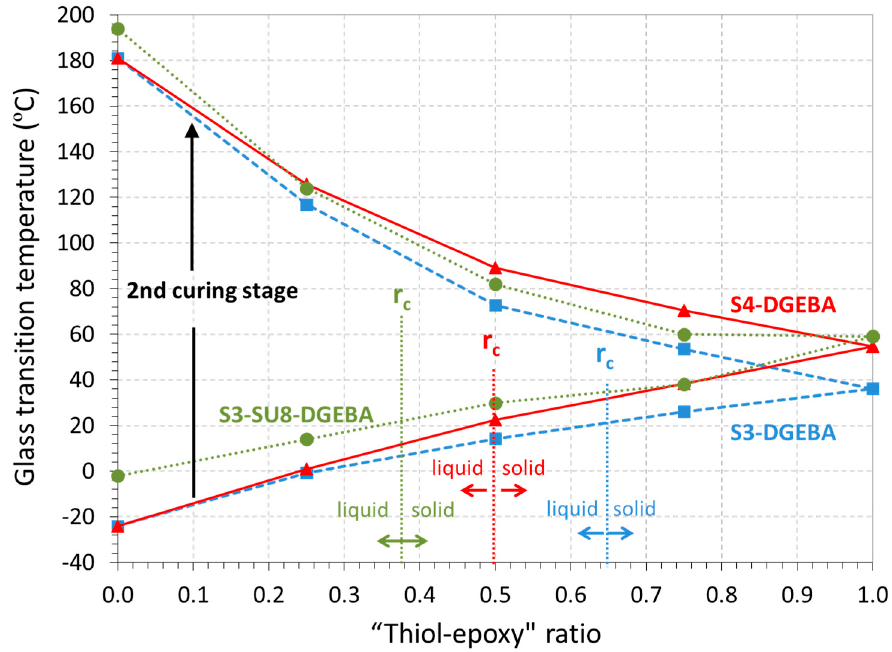
Figure 7. Glass transition temperatures and critical ratio for the different systems of study at different “Thiol–epoxy” ratios.